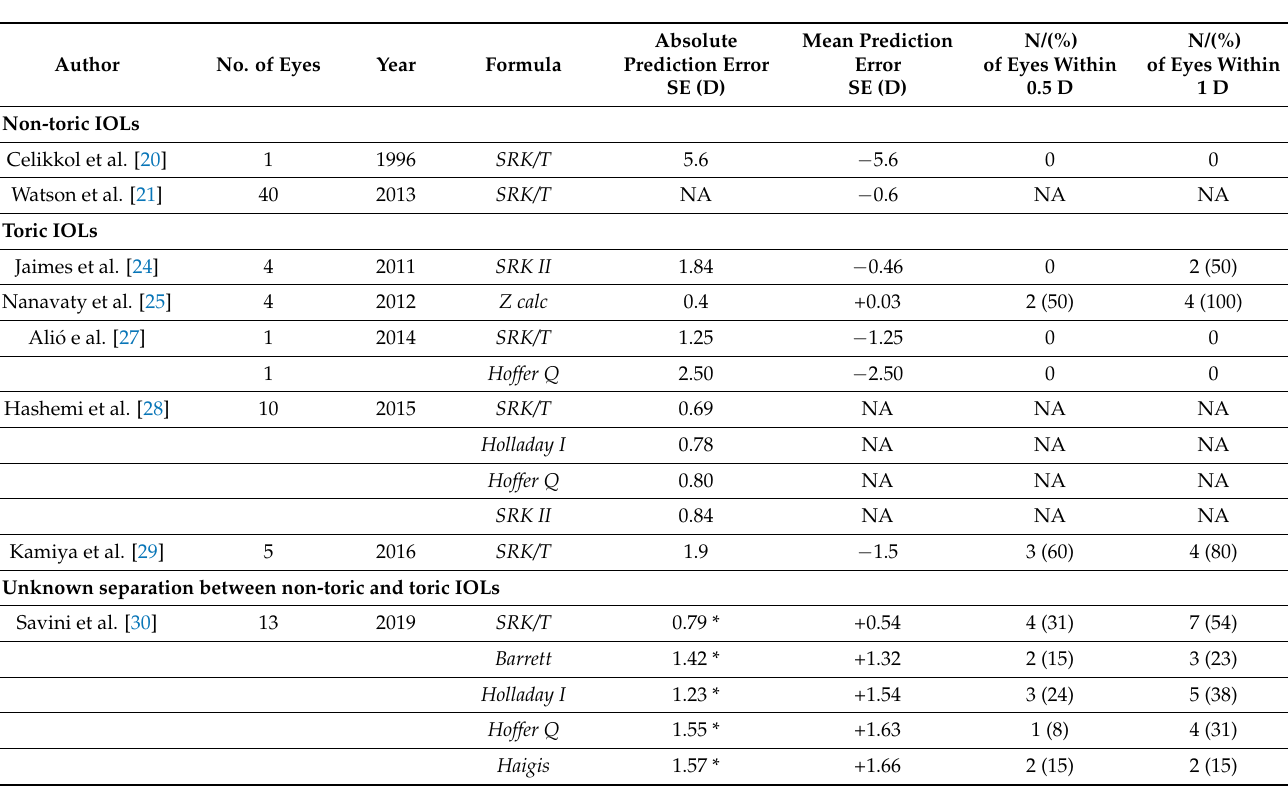
Table 3. Mean error in non-toric and toric IOL power calculation in keratoconus stage II eyes based on Krumeich